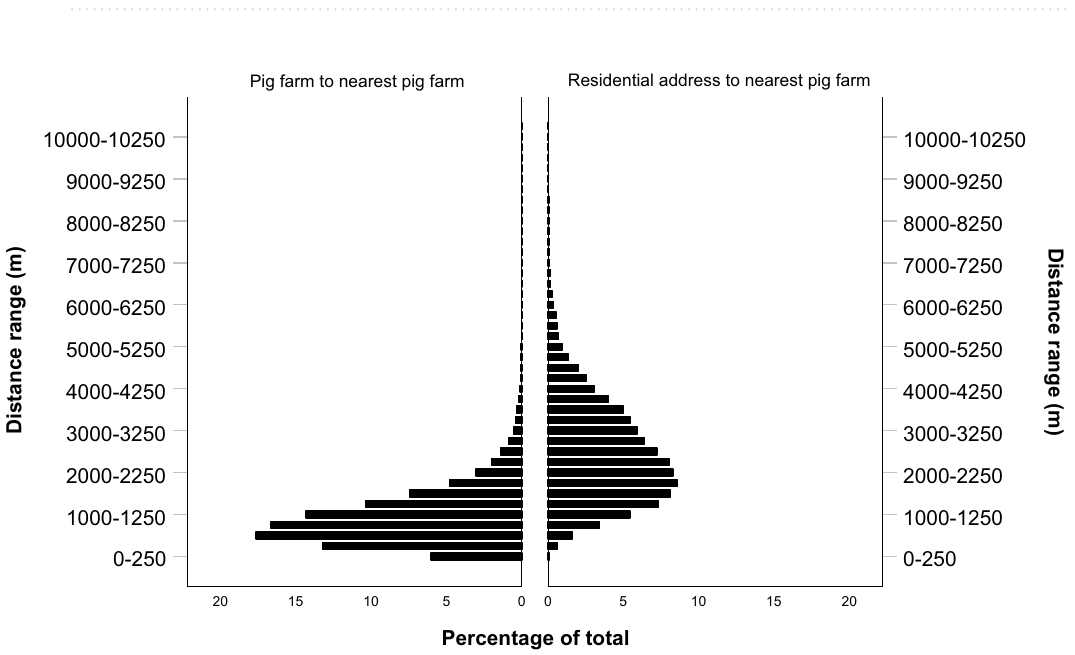
Figure 4. Distance distribution of all Danish pig farms (n = 7569) to their nearest neighbouring pig farm, along with the distance distribution of all Danish residential addresses (n = 2,138,893) to their nearest pig farm. The graph displays 100% of Danish pig farms and 99.1% of residential addresses found in Denmark. Each bar represents a range of 250